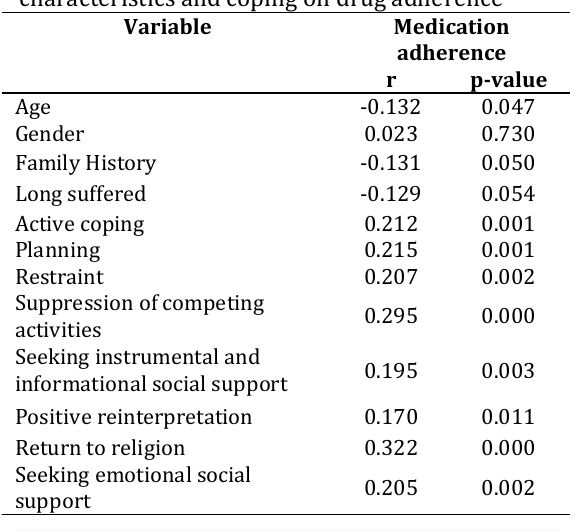
Table 4. Relationship between demographic characteristics and coping on drug adherence